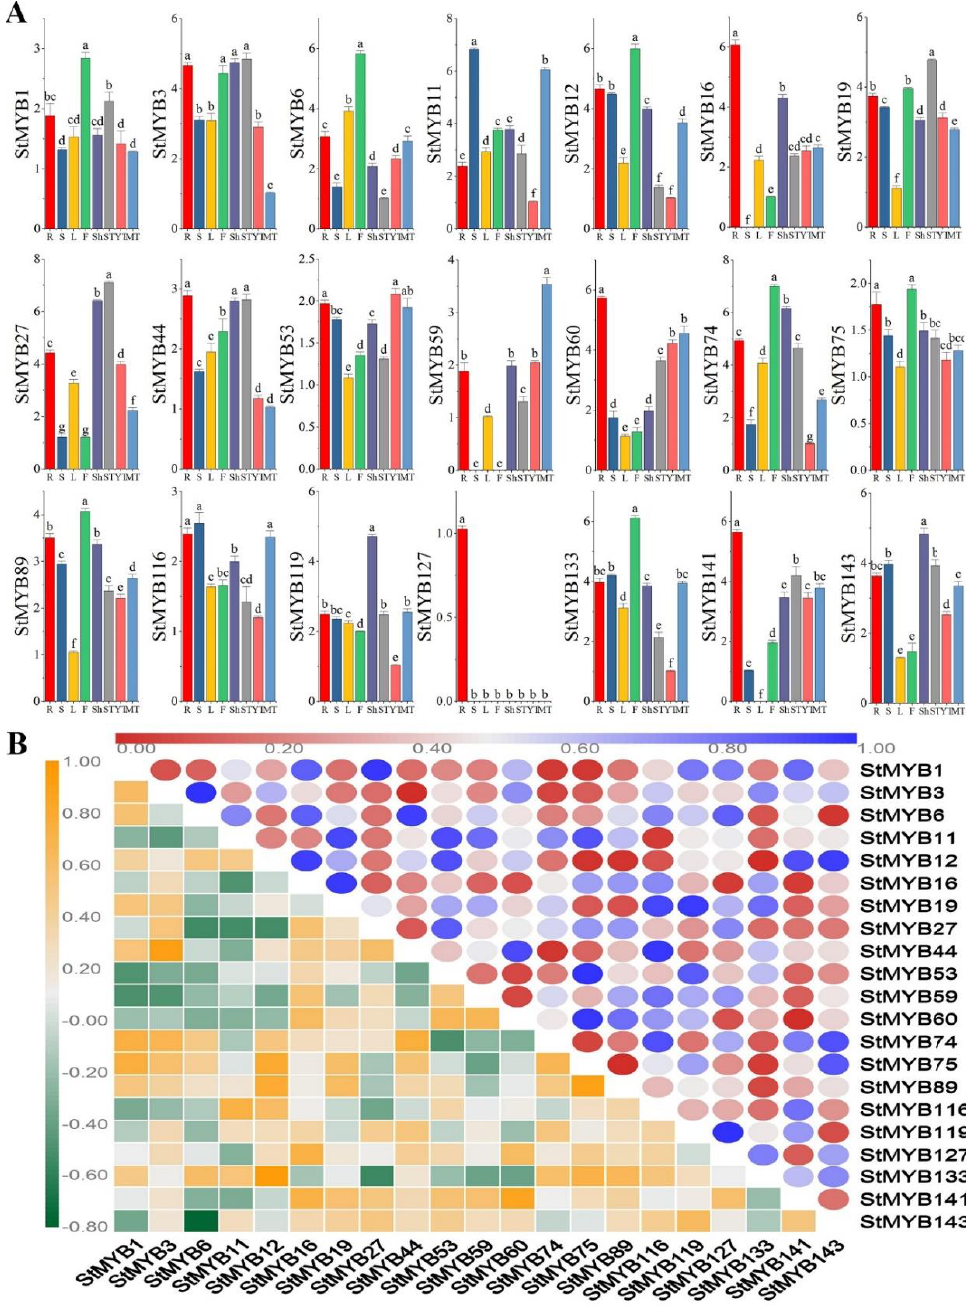
Figure 7. Tissue-specific gene expression of 21 potato MYB genes and the correlation between the gene expression patterns of StMYBs . ( A ) The expression patterns of 21 potato MYB genes in roots, stems, leave, flowers, shoots, stolons, young tuber, and mature tuber were examined by quantitative real-time polymerase chain reaction (qRT-PCR). The expression pattern of each gene was calculated based on the minimum expression of each gene in di ff erent tissues. Error bars were obtained from three measurements. Lowercase letter(s) above the bars indicate significant di ff erences ( α = 0.05, least significant di ff erence (LSD)) among the treatments. ( B ) Di ff erent colors represent the correlation of StMYB gene expression patterns in di ff erent tissues. Di ff erent colors in the lower left corner represent the correlation of StMYB gene expression patterns in different tissues, while the different colors in the upper right corner represent the p -value of the correlation.